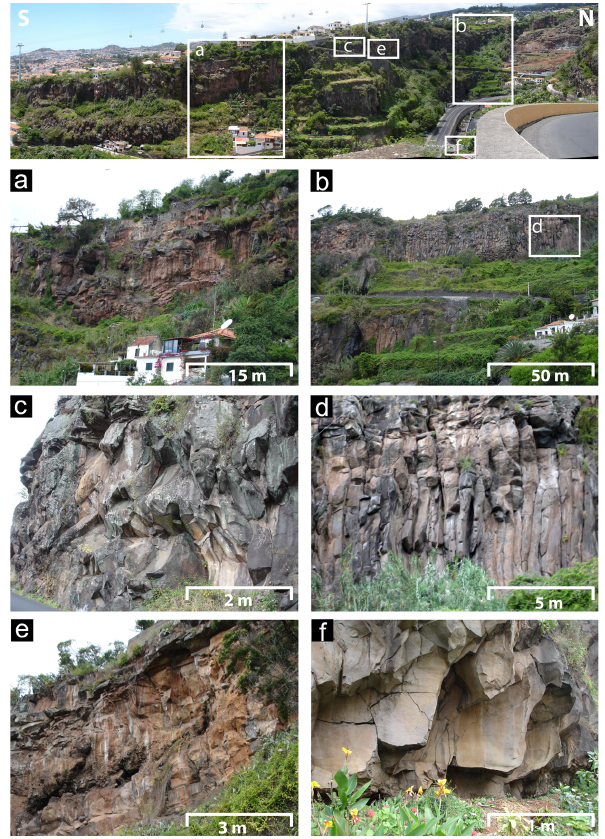
Fig. 2. Panorama of east exposed slopes in the study area (top). Steep slopes over houses (a) and streets (b) consist of thick basaltic lavaflows (c) with columnar jointing structures, lacking basal support (d) . Within the slopes: notches, overhangs (e) and open cracks are common (f) .